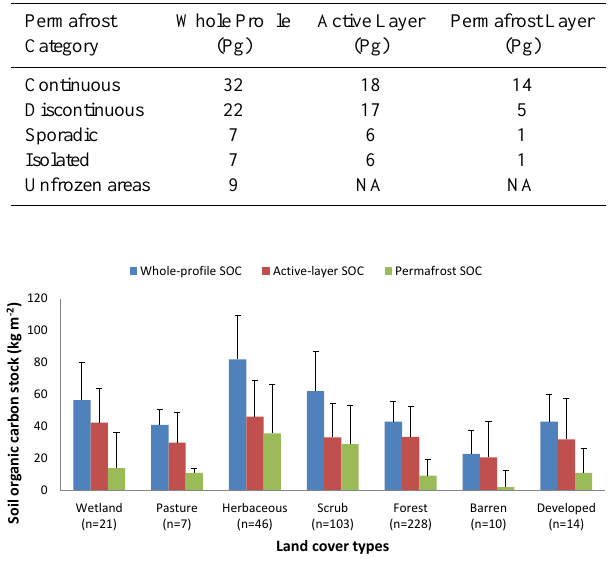
Fig. 3. Predicted average whole-profile, active-layer, and permafrost SOC stocks under different land covers in Alaska. Error bar is the standard deviation and n is the number of Figure 3.